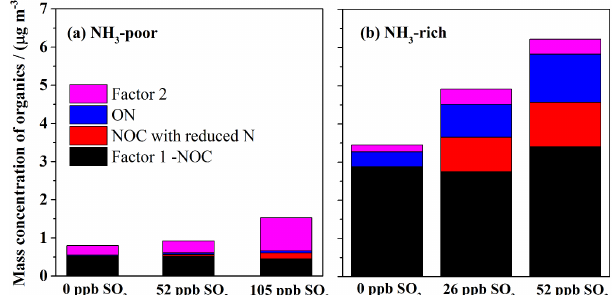
Figure 9. The estimated concentrations of NOC (ON and NOC with reduced N) and the two factors (identified by PMF analysis) in SOA as a function of SO 2 concentration in photooxidation of toluene / NO x under (a) NH 3 -poor and (b) NH 3 -rich